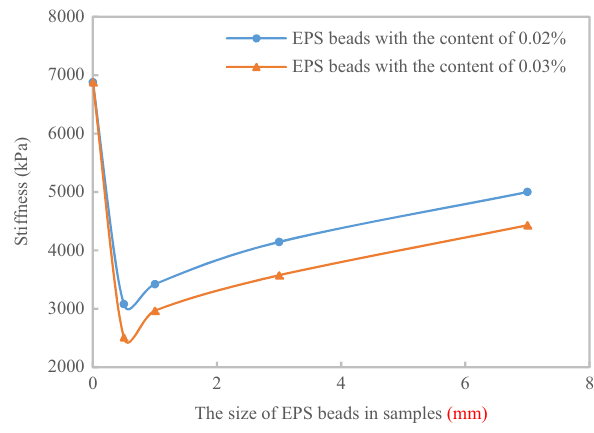
Figure 12: The relationship between the size of EPS beads in sam - ples and sti ff